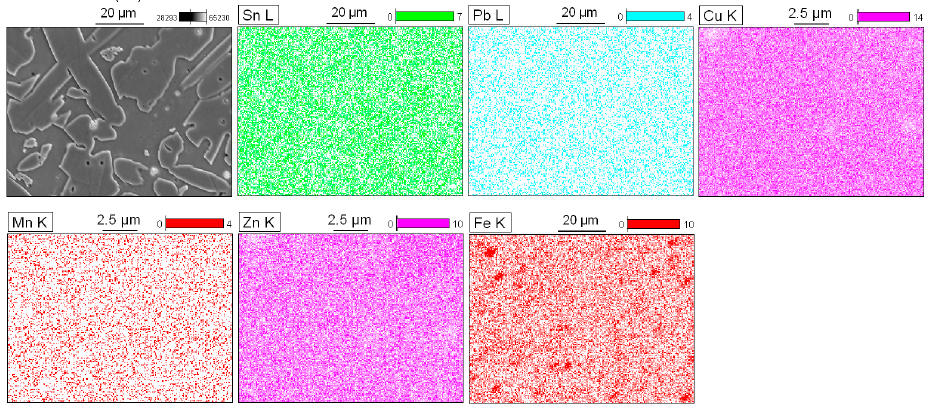
Figure 4. Qualitative scanning of the energy dispersive X-ray spectroscopy (EDS) map, with distributions of the elements Sn, Pb, Cu, Mn, Zn, and Fe in the alloy.